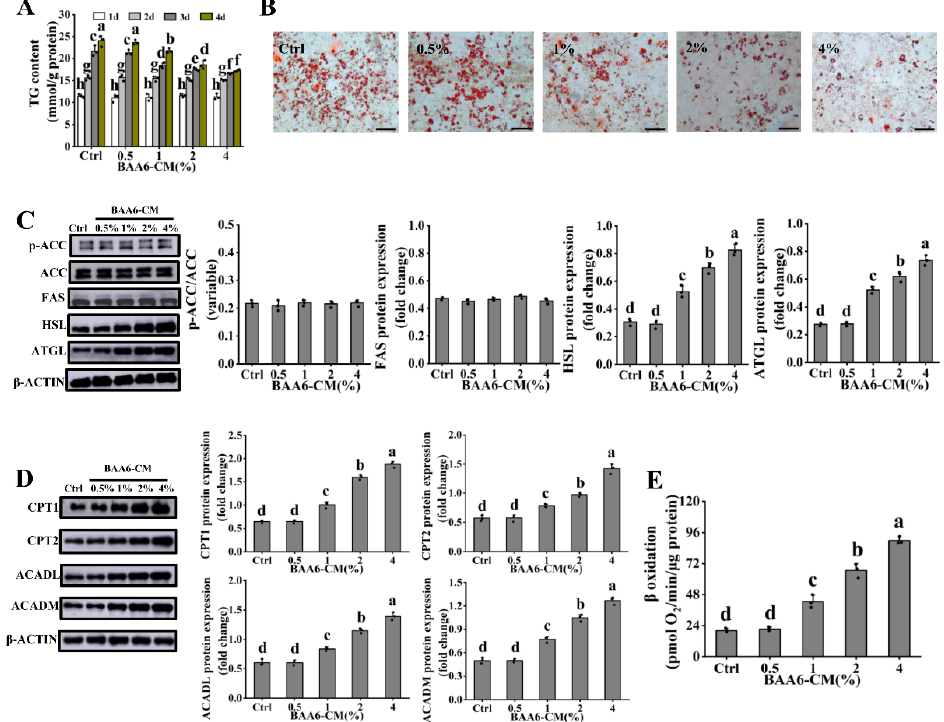
Figure 3. Effect of BAA6 culture supernatant (BAA6-CM) on TG content and FAO in 3T3-L1 cells. ( A ) TG concentration, in the presence of BAA6-CM (0–4%), for 1–4 days. ( B ) Photograph of Oil Red O (ORO) staining (scale bar, 200 μm) and western blot analysis, showing the levels of ( C ) p-ACC, FAS, HSL, and ATGL, and ( D ) levels of protein expression of CPT1, CPT2, ACADL, and ACADM after treatment with 0–4% BAA6-CM for 3 days. ( E ) β oxidation, measured by Seahorse XF platform, following various concentrations of 0–4% BAA6-CM for 3 days. Values are shown as means ± SD. Different lowercase letters mean remarkable differences between groups at p < 0.05.